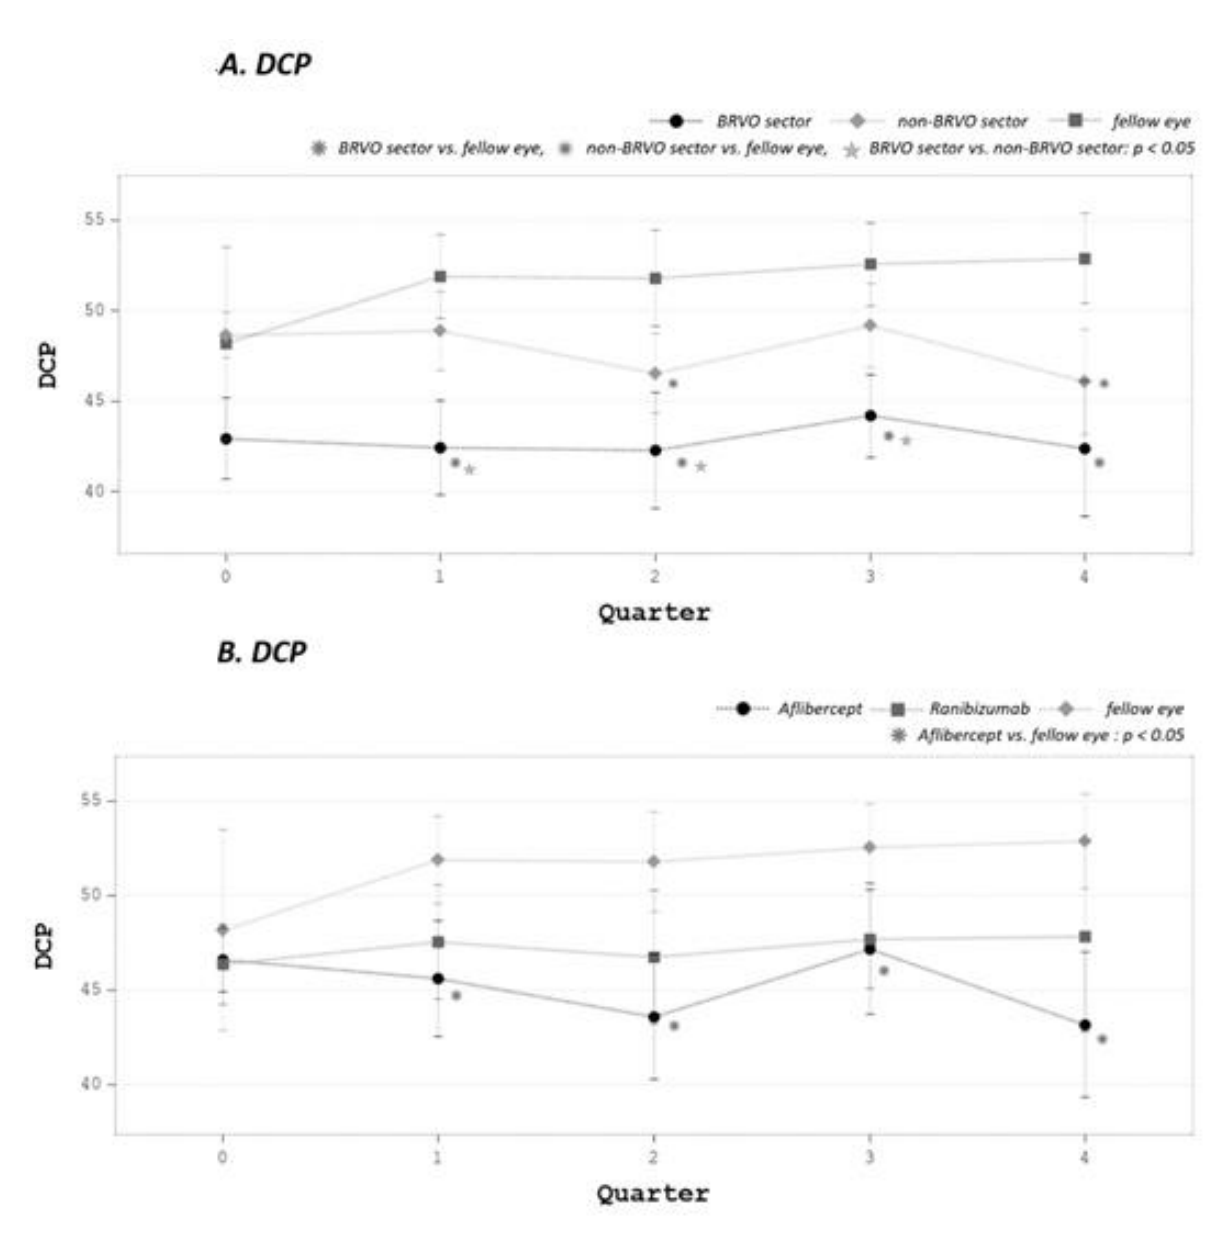
Figure 3. ( A ) DCP in BRVO sectors remained low after the initiation of treatment and reached significance compared with non-BRVO sectors and fellow eye ( p < 0.05). ( B ) In subgroup analysis, the significance was mostly in the aflibercept group.